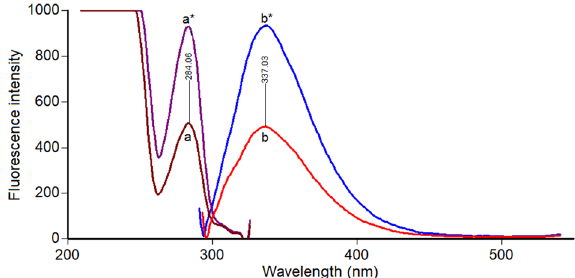
Figure 2. Excitation (a, a*) and emission (b, b*) spectra of PHL in acetonitrile at concentrations of 1.2 and 2.4 μg/mL.